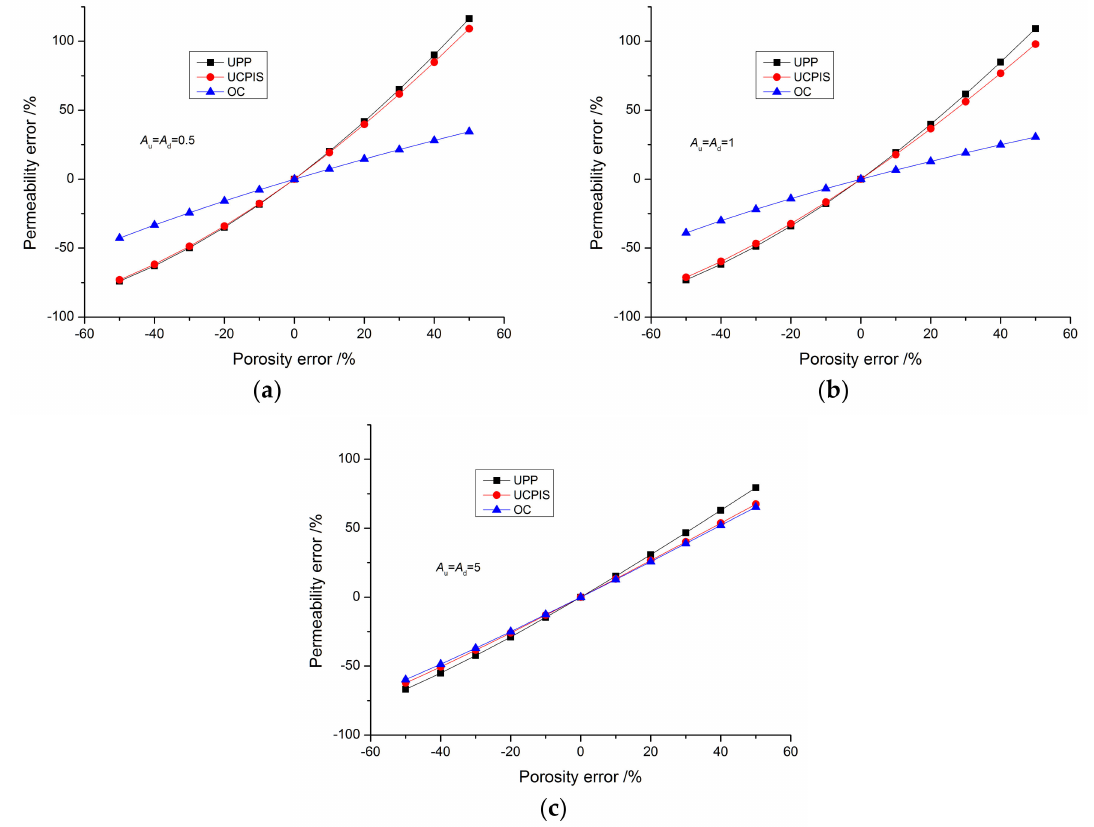
Figure 4. E ff ect of the porosity error on the permeability precision: ( a ) A u = A d = 0.5; ( b ) A u = A d = 1; ( c ) A u = A d =